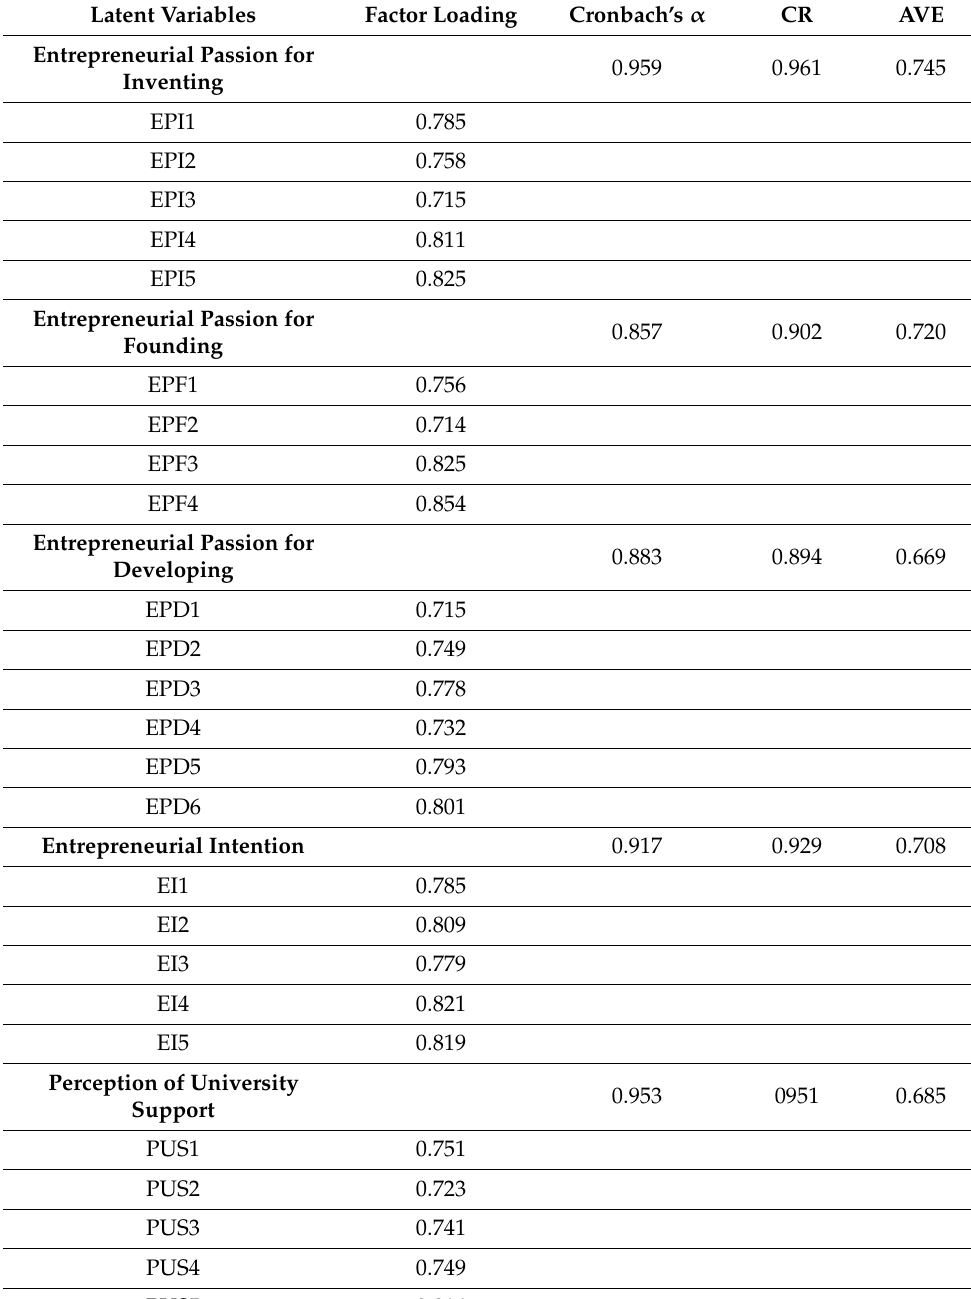
Table 1. Measurement model (FL, Cronbach’s α , CR, and